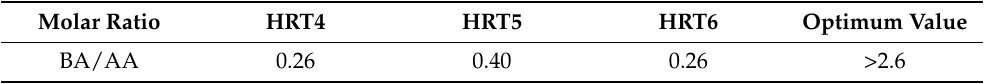
Table 5. Butyric acid to acetic acid (BA/AA) molar ratio for the three HRTs. Molar Ratio HRT4 HRT5 HRT6 Optimum Value BA/AA 0.26 0.40 0.26